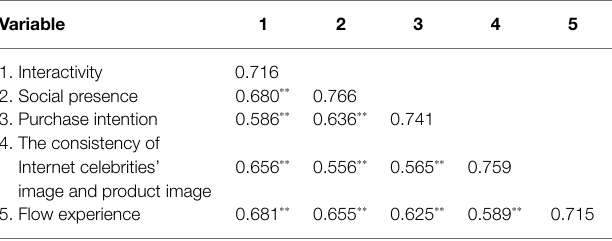
TABLE 1 | Descriptive statistics and correlation coefficients and discriminant validity